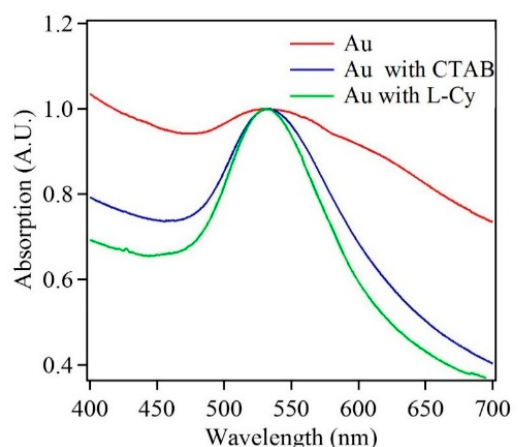
Figure 10. Absorption spectra of Au nanoparticles after the first deposition cycle in the absence and presence of surfactants.